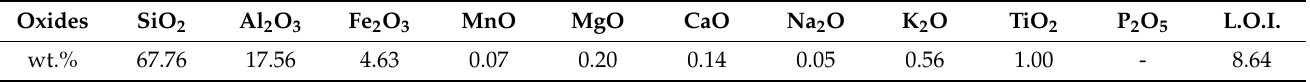
Table 2. Chemical composition of the soil used in this study (L.O.I.: loss on ignition). Oxides SiO